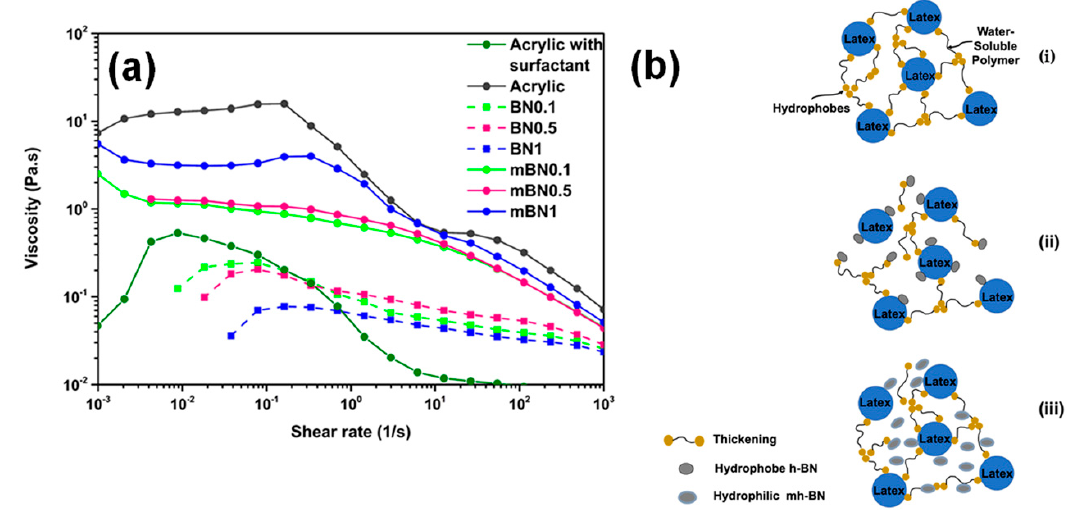
Figure 7. ( a ) Shear rheological curves of the acrylic resin and the formulations with unmodified (h-BN) and plasma-modified (mh-BN) nanoparticles, ( b ) the scheme of possible interactions between the latex nanoparticles, thickening and h-BN nanoparticles ( i ) acrylic resin ( ii ) acrylic coating with modified nanoplatelets and ( iii ) acrylic coating with unmodified nanoplatelets.